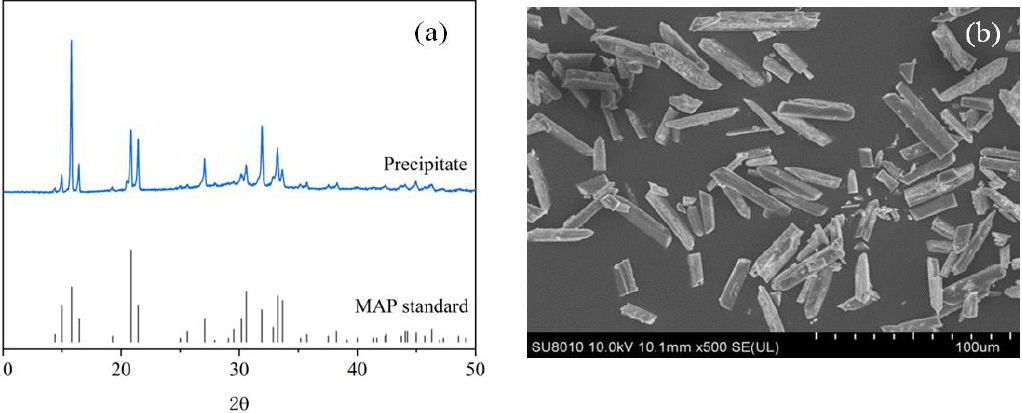
Figure 6. XRD pattern ( a ) and SEM images ( b ) of the precipitate. Table 5. PRE and struvite purity of precipitate obtained from the HTSS and desorption solution.